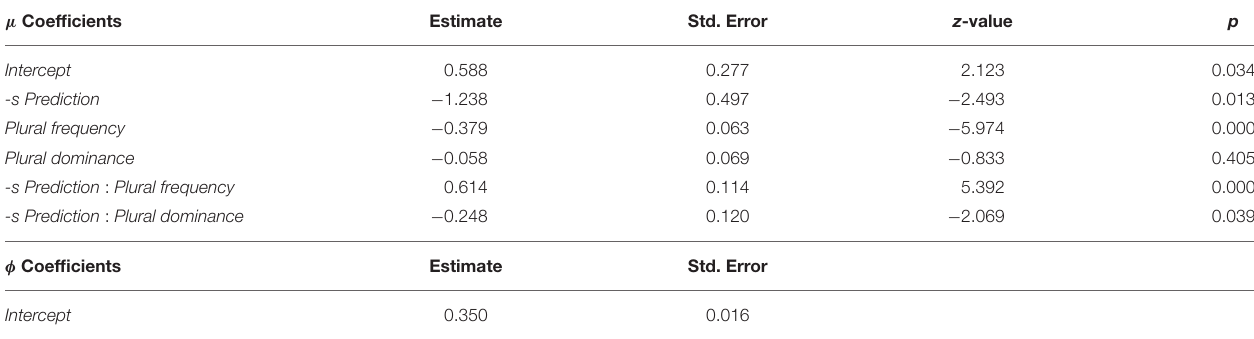
TABLE 3 | Beta-binomial model of -s